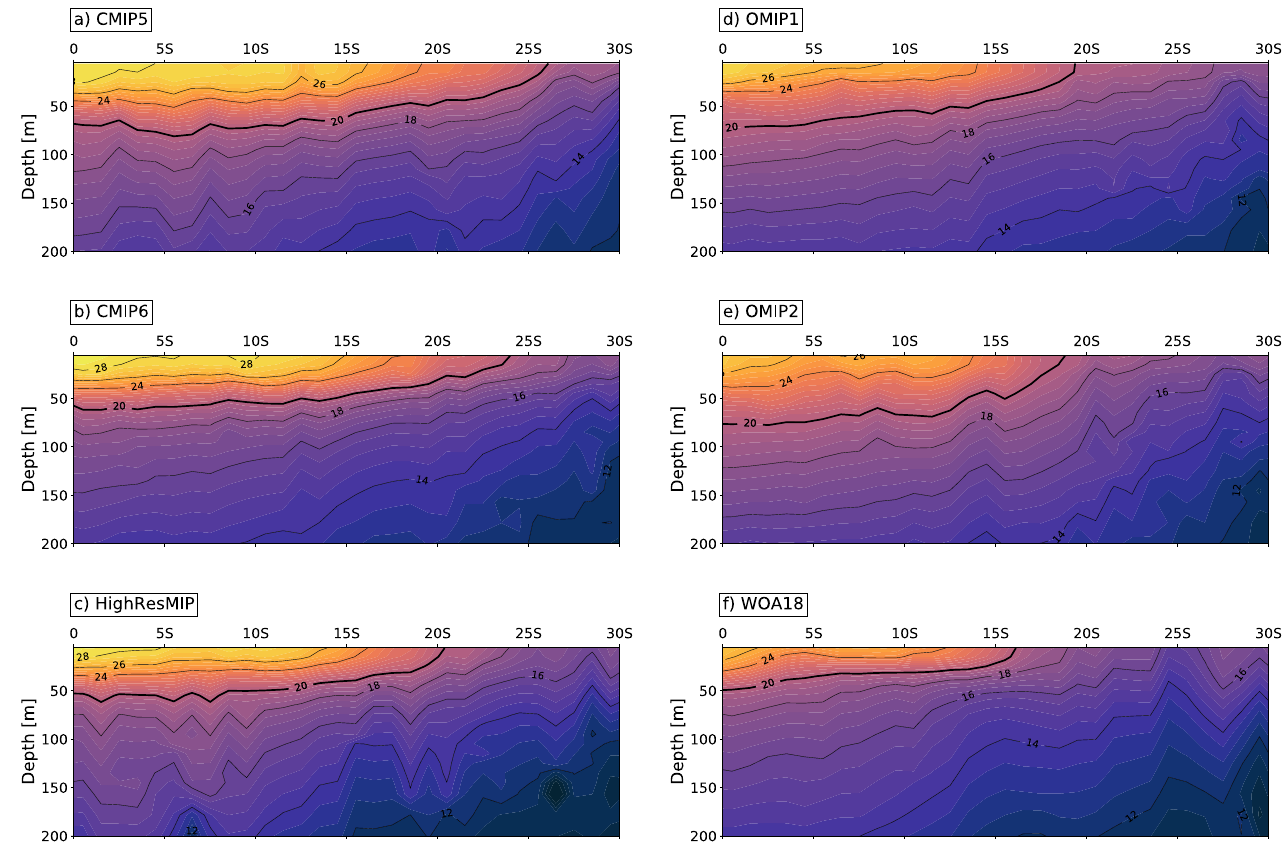
Fig. 5 Alongshore subsurface temperature pro fi les. Time-mean subsurface temperature pro fi les along the African coast, zonally averaged over a 2 ∘ wide band along the coast, for all MMMs and WOA18. Contour interval is 2 ∘ C. The 20 ∘ C isotherm is highlighted in